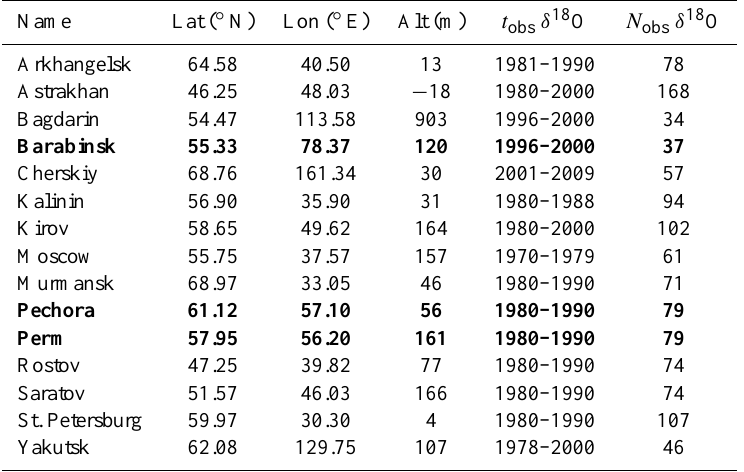
Table 1. GNIP δ 18 O records from Russia considered in this study. Stations located in western Siberia are highlighted in bold. For each station, we report the latitude, longitude and altitude, as well as the sampling period ( t obs ) and the number of available monthly measurements ( N obs